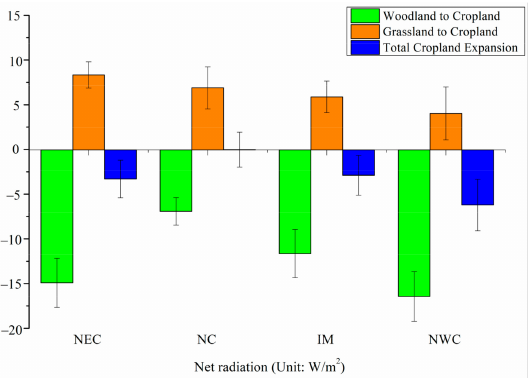
Figure 8. Change of net radiation due to cropland expansion in different zones.